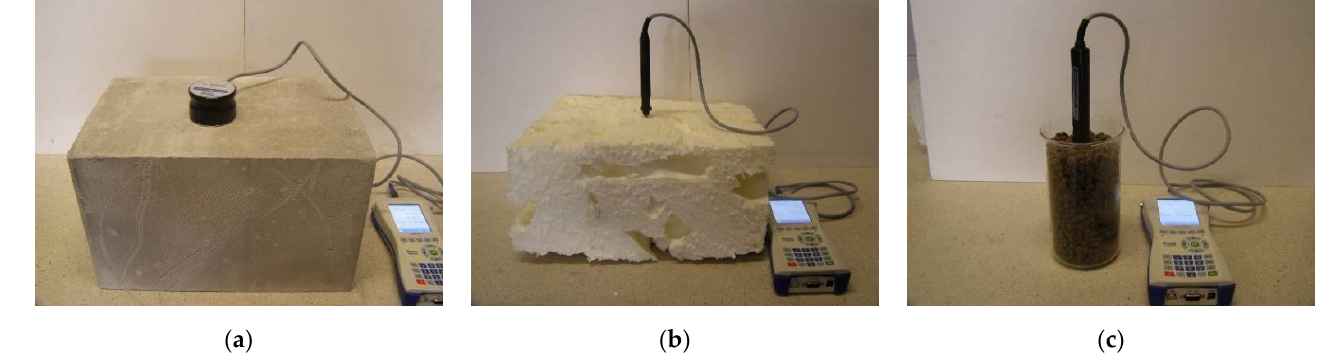
Figure 1. Testing of perlite concrete with a surface probe ( a ), testing of PUR foam with a needle probe ( b ), and testing of expanded clay with a needle probe ( c ).